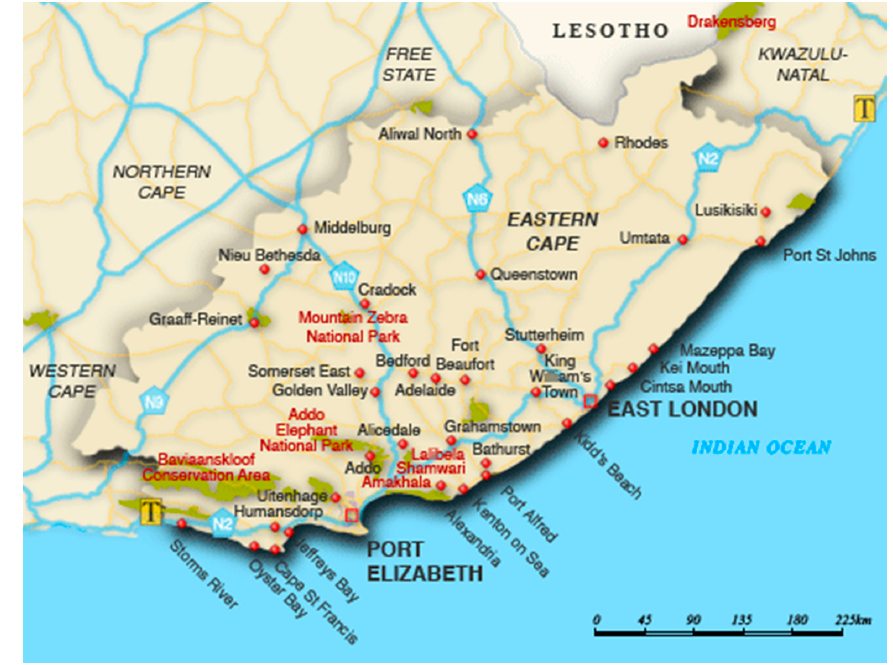
Figure 1. Map showing Eastern Cape Province, South Africa. Map data ©2016 AfriGIS (Pty) Ltd., Google.